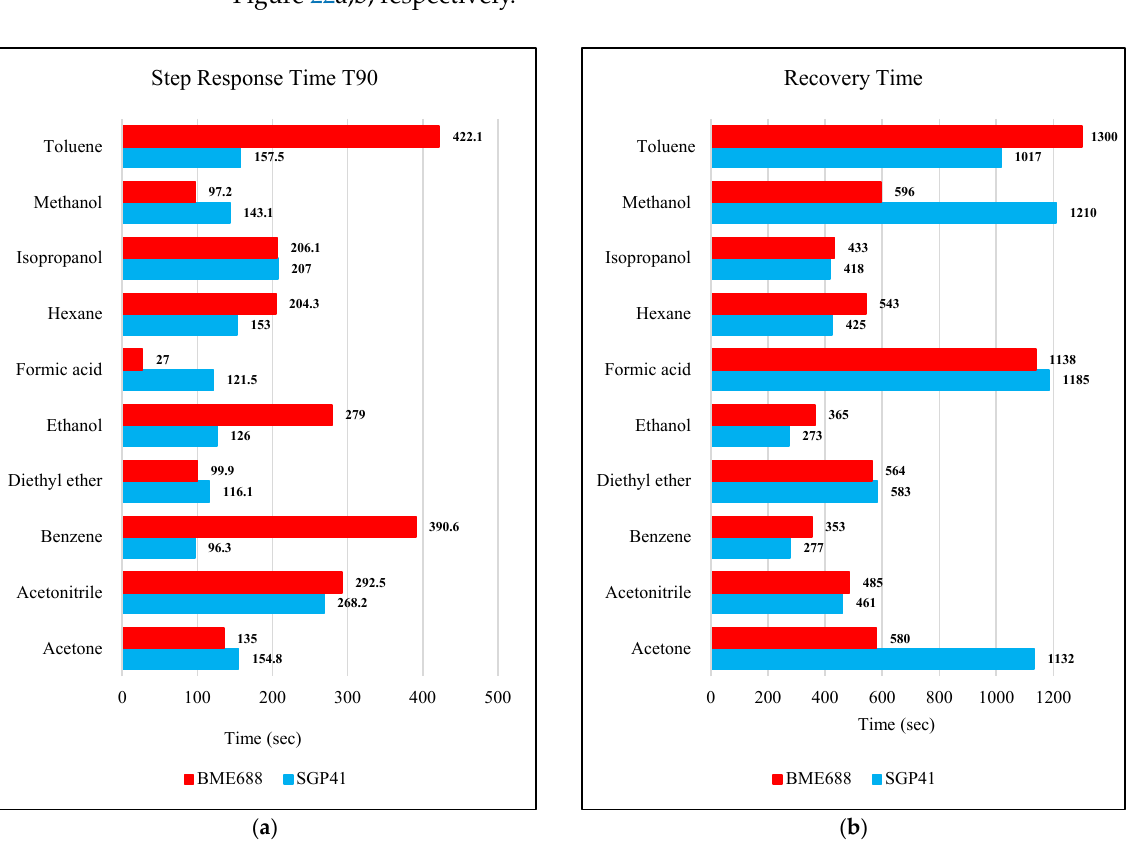
Figure 22. ( a ) SGP41 VOC-Index and BME688 IAQ-Index step response time T90 for selected VOCs of 100 µL volume from a 40 cm distance between the sensors and the leakage source, ( b ) SGP41 VOC-Index and BME688 IAQ-Index recovery time for selected VOCs of 100 µL volume from 40 cm distance between the sensors and the leakage source.